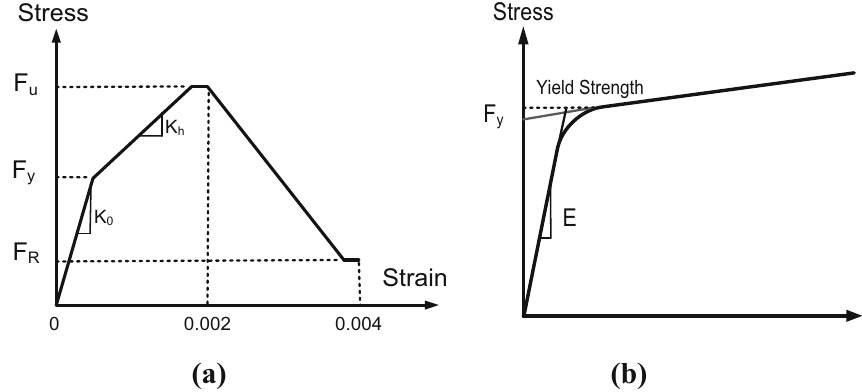
Fig. 5 Nonlinear models for reinforced concrete. a Concrete and b reinforcing steel.